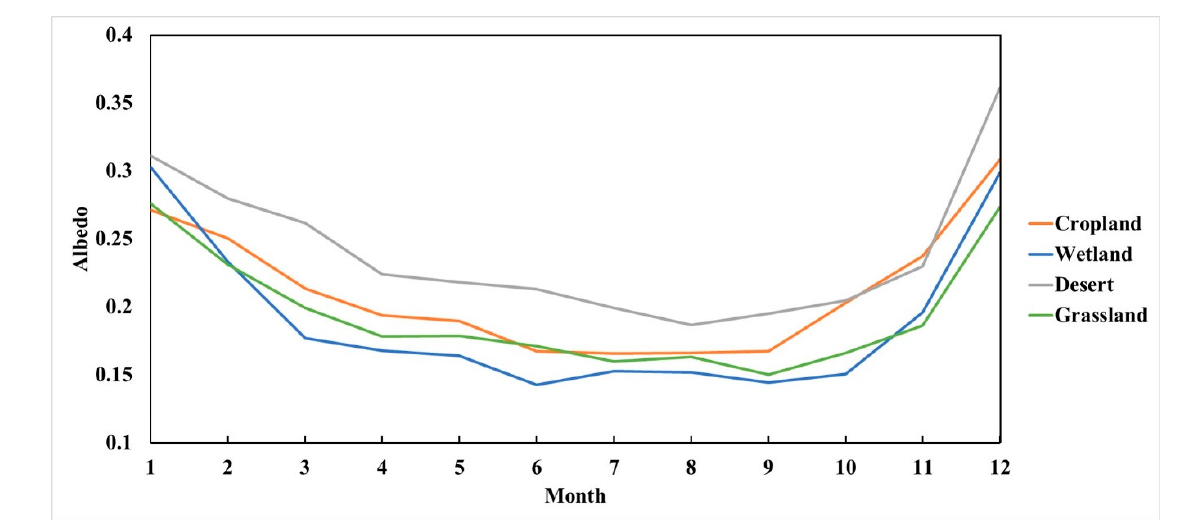
Figure 5. Annual variation in monthly mean albedo under different land cover types.